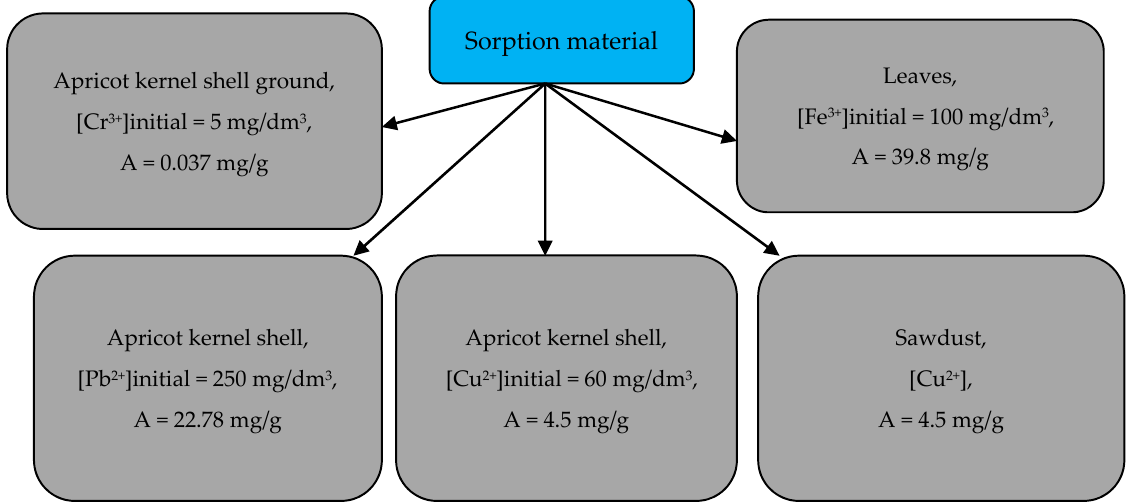
Figure 7. Sorption capacity of leaves, sawdust and apricot kernel shells in relation to some heavy metal ions.